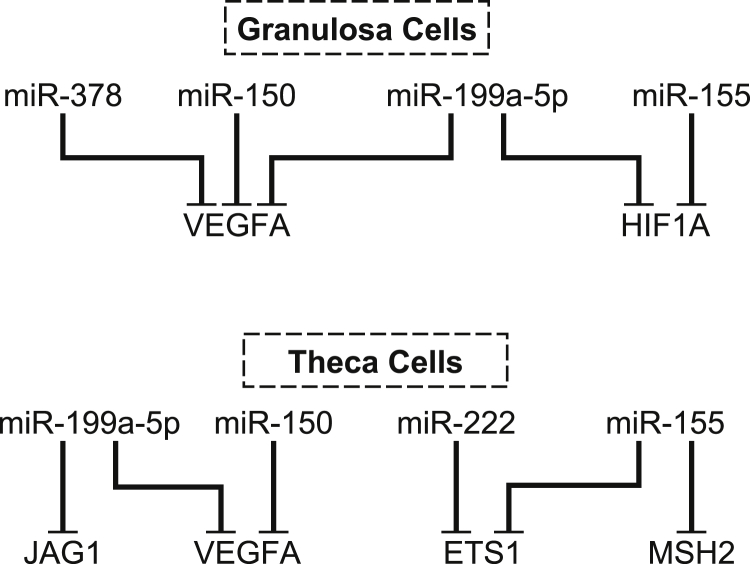
Schematic summary of putative miRNA target interactions in granulosa and theca cells during follicular atresia identified in this study. miRNA, micro RNA.